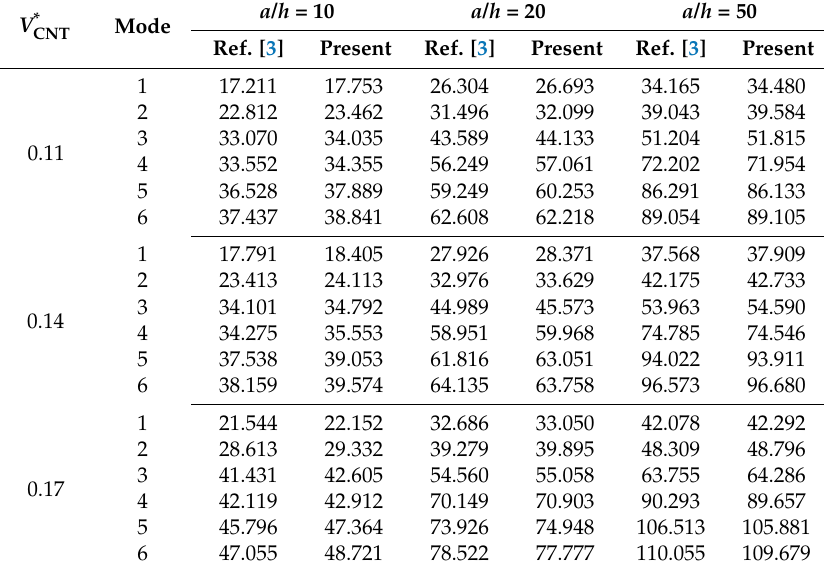
Table 5. Dimensionless first six natural frequencies ω for an FG-V CNT-reinforced square plate with a/h ratios.